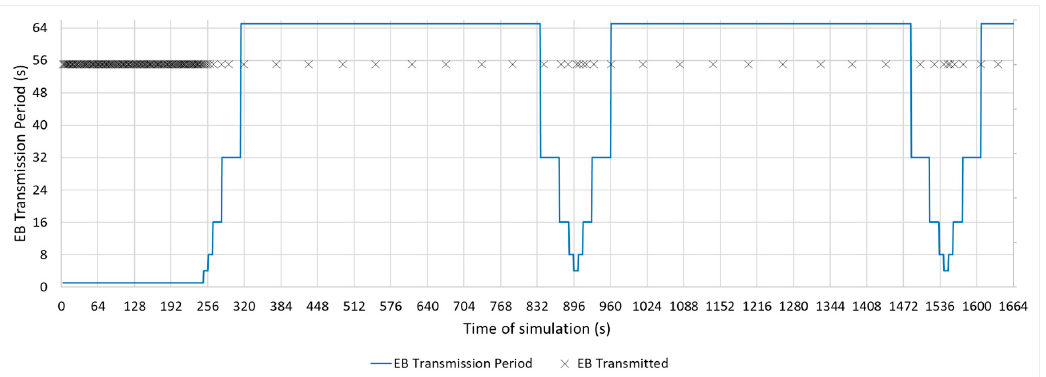
Figure 9. Bell-32 Configuration.